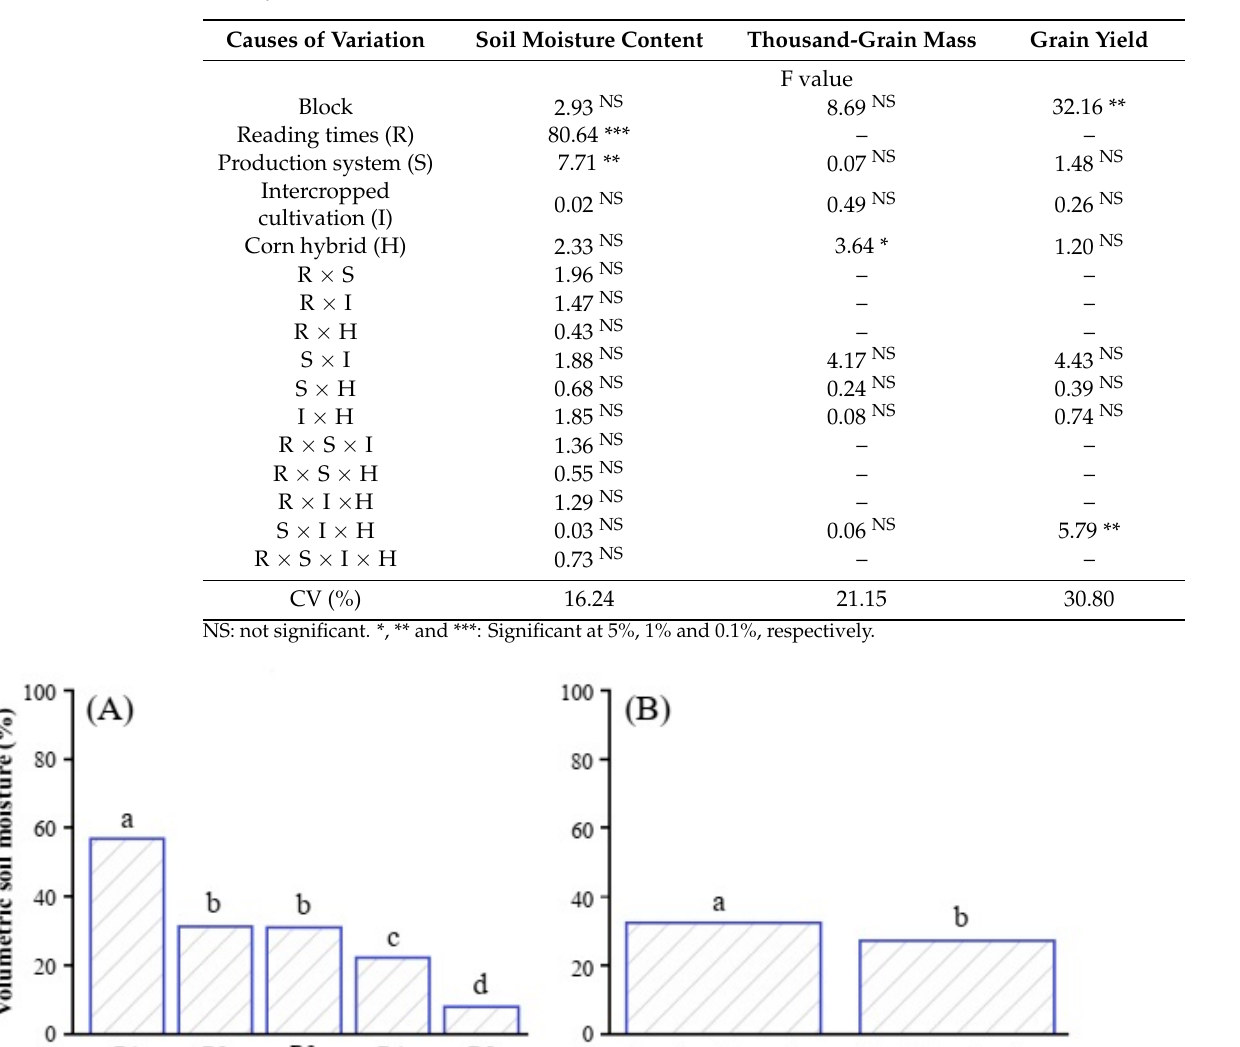
Table 4. Summary of analysis of variance for soil moisture content, thousand-grain mass, and corn grain yield in response to soil moisture reading times, agricultural production systems (agroforestry and traditional system), intercropped and nonintercropped cultivation of corn with ruziziensis and corn hybrids.